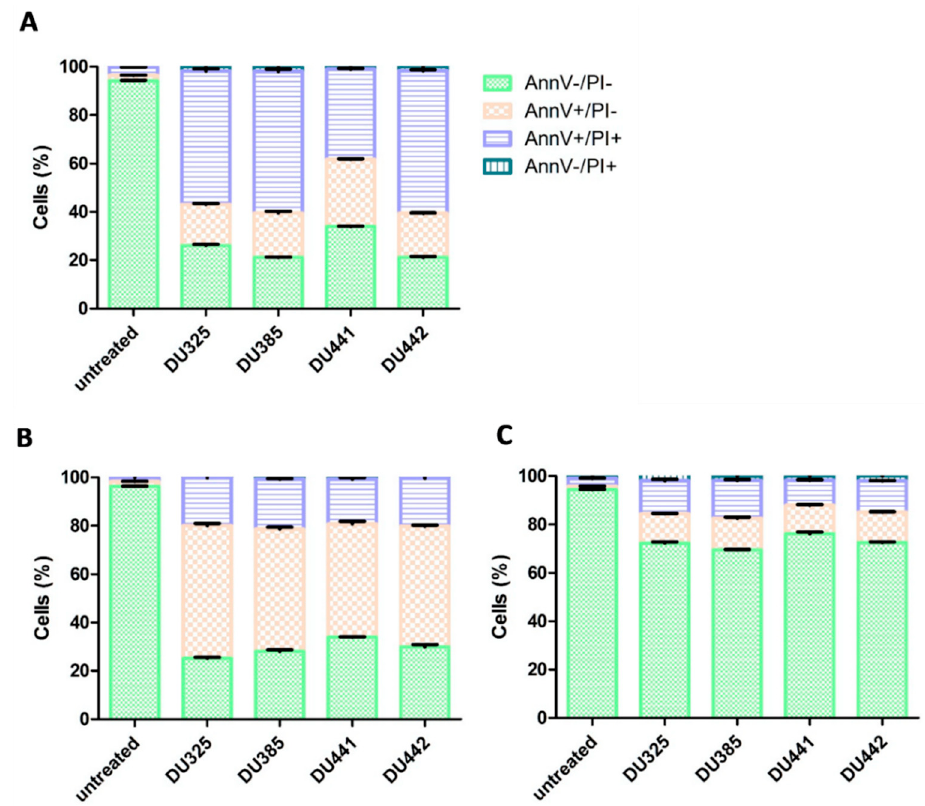
Figure 2. Imidazo[1,2- b ]pyrazole-7-carboxamides induced phosphatidylserine exposure on